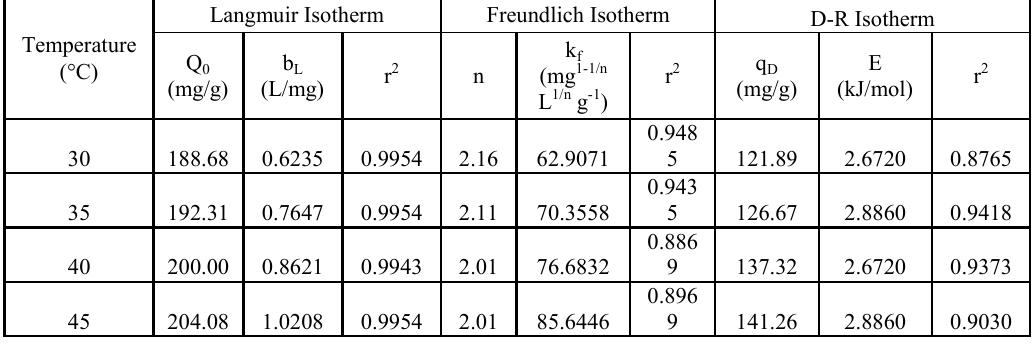
Table 2: Isotherm Constants for the adsorption of AV49 dye onto PAC at various Temperatures . Langmuir Isotherm Freundlich Temperature (°C)